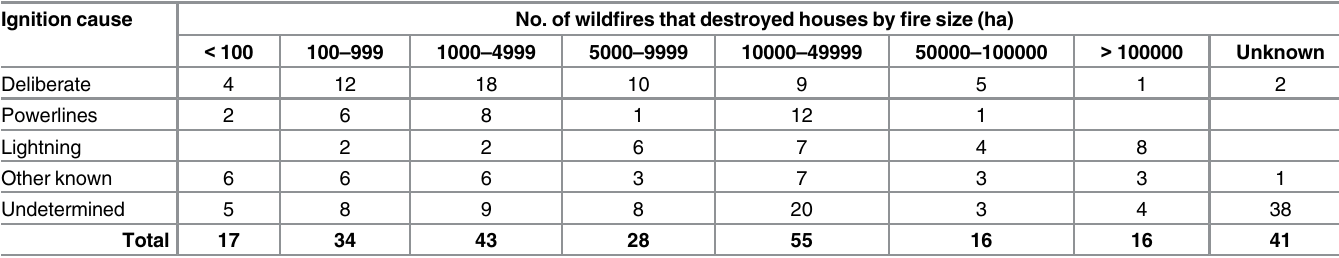
Table 3. The number of wildfires that destroyed houses from 1951 to 2015 classified by ignition cause and fire size (ha). Ignition cause No. of wild fi res that destroyed houses by fi re size